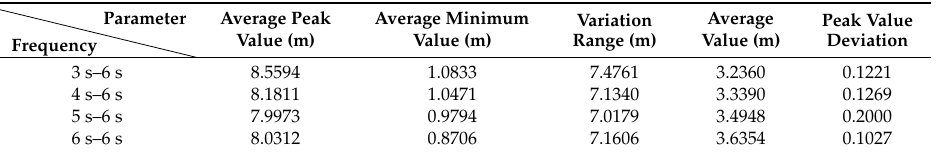
Table 7. Pressure values and analysis after air inflow has been cut off for 6 s (rectangular nozzle at the bottom of the pipe).